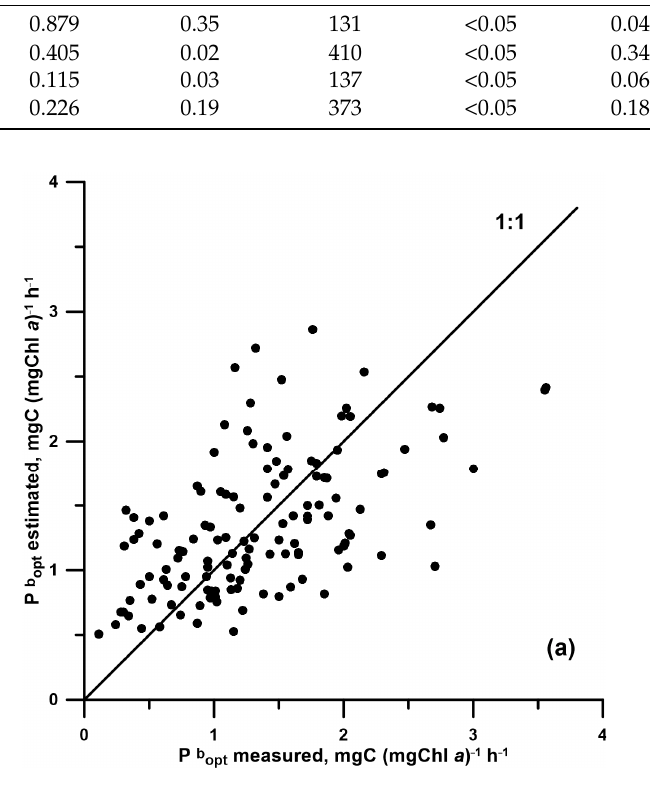
Table 6. Regression statistics and performance indices for the log-transformed measured and mod- elled optimal assimilation number (P b opt ). Slope and intercept are parameters of the linear regressions; R 2 —coefficient of determination; N —number of data used for model validation; p -value indicates the significance level of each regression. Indices are the mean model bias (B), the standard deviation of the log-transformed modelled values of P b opt ( σ ), and the root-mean-square difference (RMSD); E 0reg —the region-specific P b opt model developed using subsurface photosynthetically available radiation (PAR) and verified with field data. BF-model—the P b opt model developed by Behrenfeld and Falkowski [13]. T reg —the region-specific P bopt model developed using the relationship be- tween P bopt and sea surface temperature. E sat —E 0reg verified with satellite-derived data of PAR.